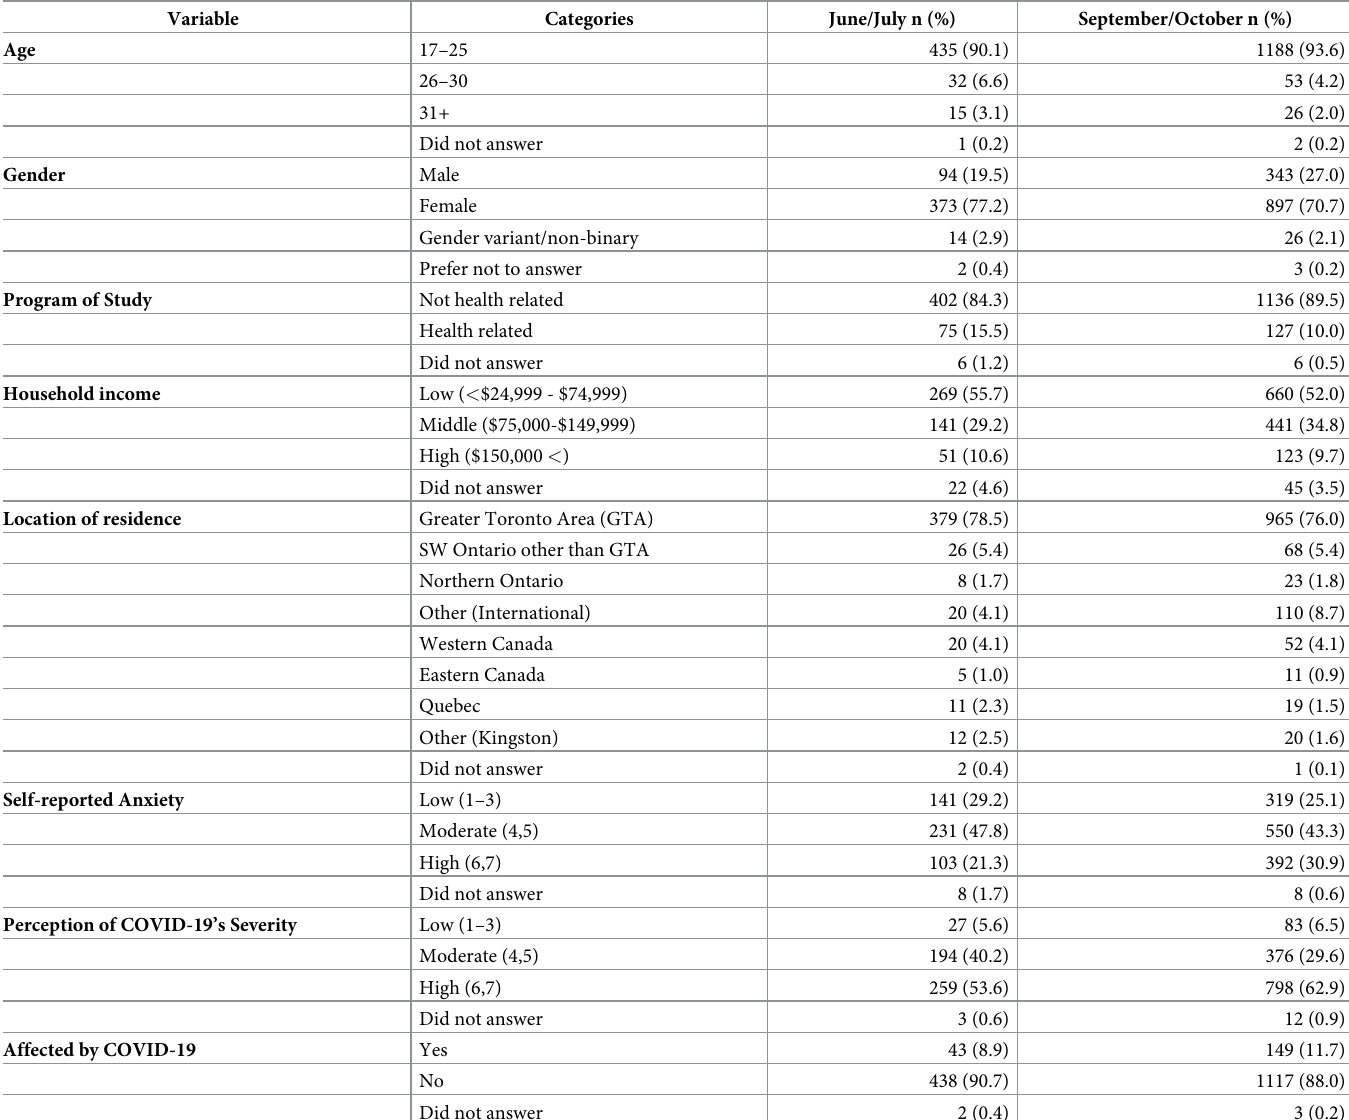
Table 1. Demographic variables.